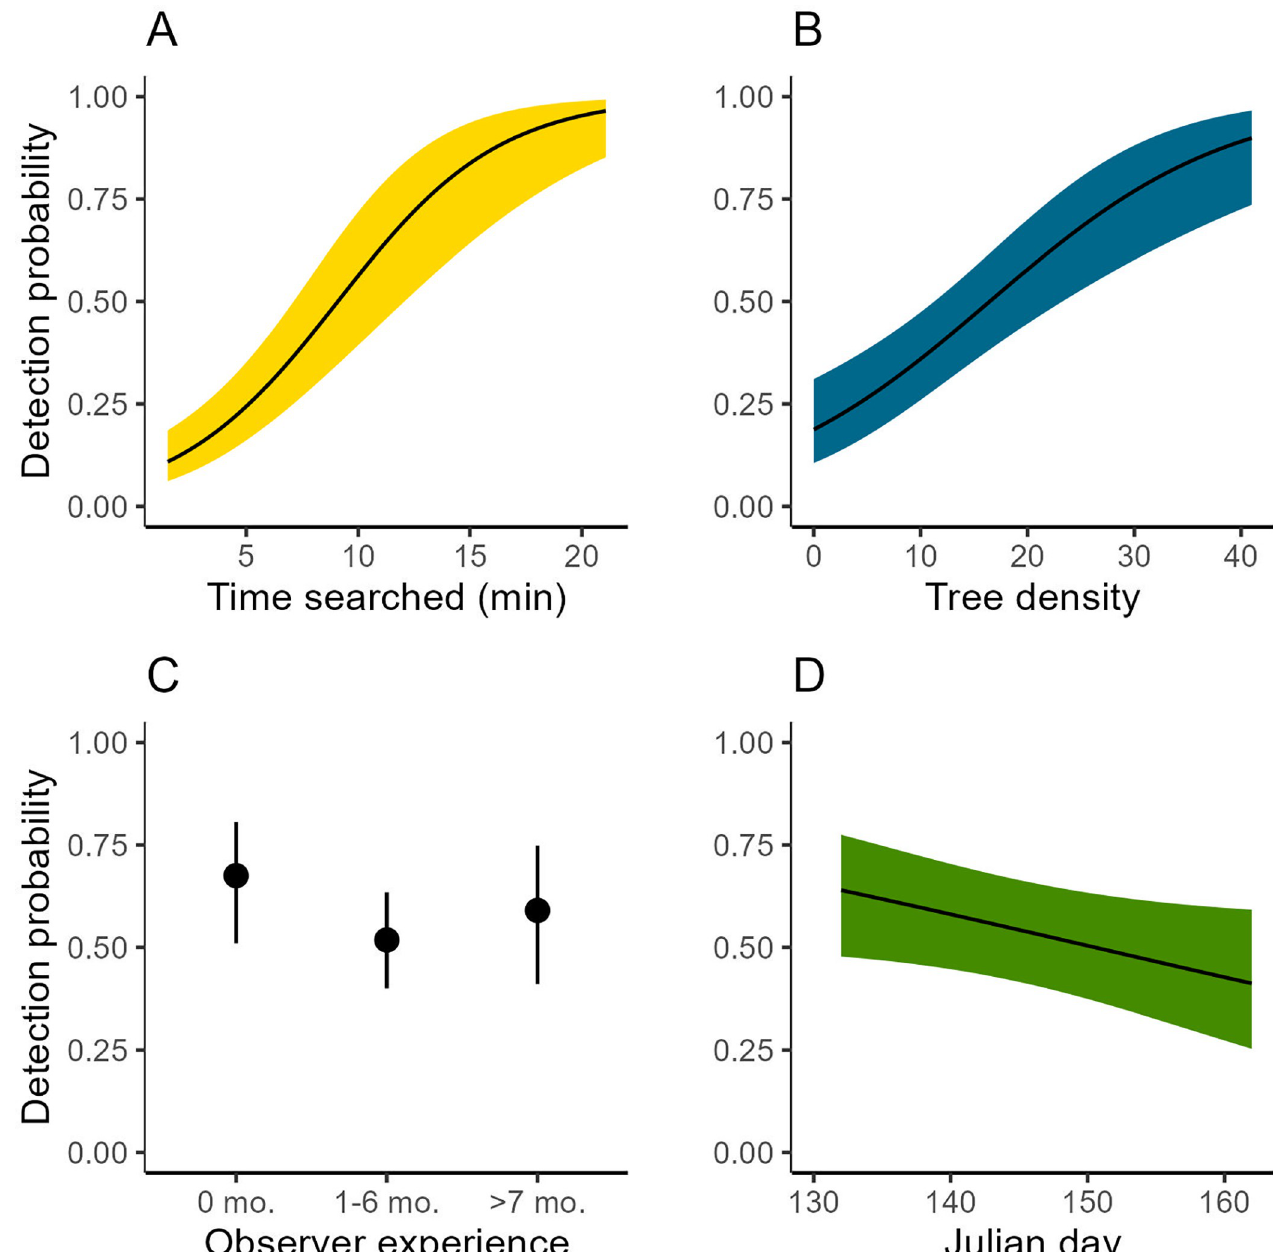
Fig 7. Prediction plots showing detection probabilities for A) the time searched in minutes; B) number of trees taller than 0.30 cm in the plot; C) prior observer experience in field research; D) Julian day that sampling occurred. Ribbons and error bars represent 95% confidence intervals. Predictions were made from models listed in Table